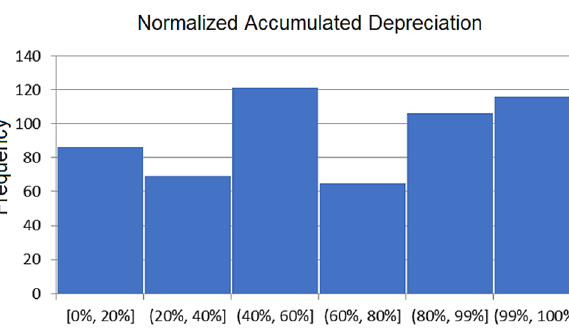
Figure 10. Histogram of accumulated asset depreciation [authors].